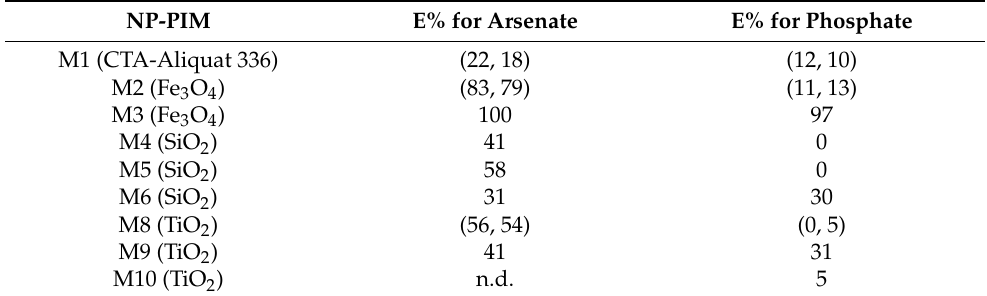
Table 4. Sorption efficiency data for the NP-PIMs after 4 h in SNW. Results for two replicates are presented in